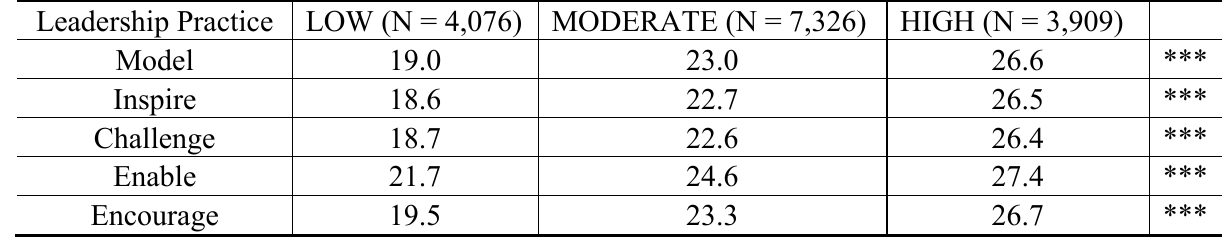
Table 11a. Comparisons by Positive Work Outcome (Observers).